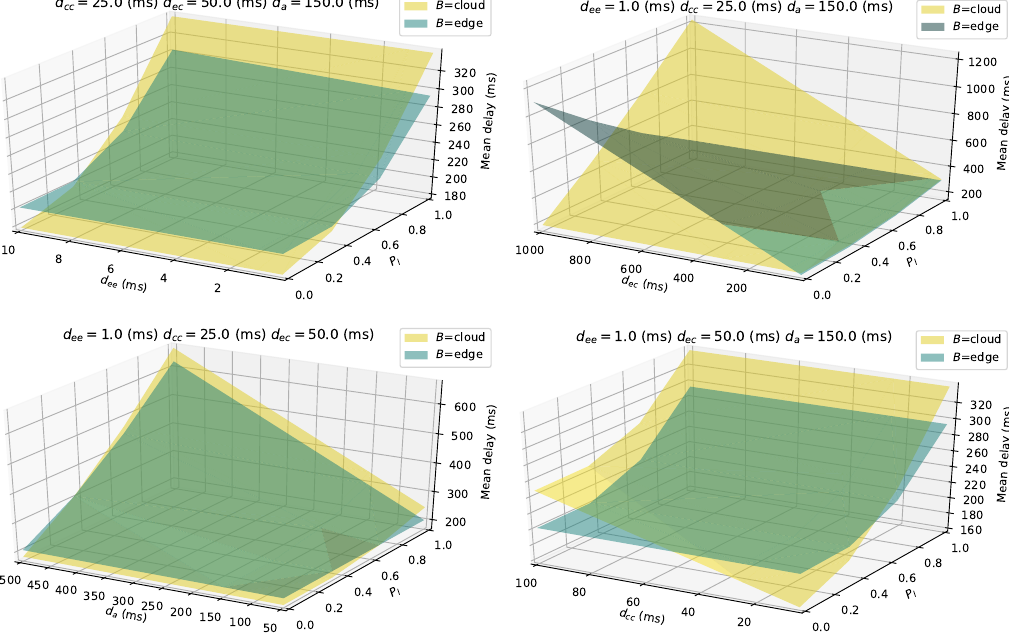
Figure 11. System performance (mean communication delay) for different propagation delays (one per chart) and different deployments, obtained by changing the number of smart thermostats whose code is executed locally ( P l ) and the deployment location of the broker (surface color). Lower values indicate better performance. The pulverized system does not require any adjustment to the business logic to tackle the diverse deployment schemes: the designer can thus use the following analysis to decide which deployment configuration to pick depending on how important it is to maximize performance. Changes in edge-to-edge delays (top left) impact performance minimally, as most of the accumulated delay is elsewhere; thus, they provide a good baseline to compare other configurations to. Changing the propagation delay between edge and cloud (top right) highlights that the worse the network performance, the more is important for the broker to be close to where the computation components of the logical system are concretely deployed. Performance of the household connection (bottom left) have higher impact on the overall performance of the CPS with the count of devices being executed locally, regardless of the broker location. This suggests that offloading the business logic to the cloud, thus sending fewer data to end devices, should be considered when the network is expected to experience high load. Finally, a difference in the delay in cloud-to-cloud communications (bottom right) is influential only for cases in which the broker is located there. If there is little or no guarantee on where the cloud components will get allocated (and hence, little knowledge about their communication performance), then adopting an edge-located broker can provide a less volatile